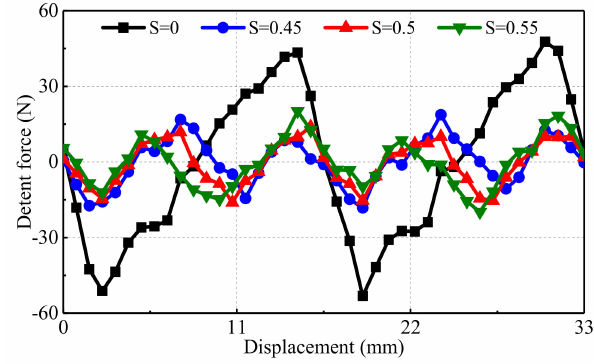
Figure 11. Detent force of the DSPMLSM with different S .